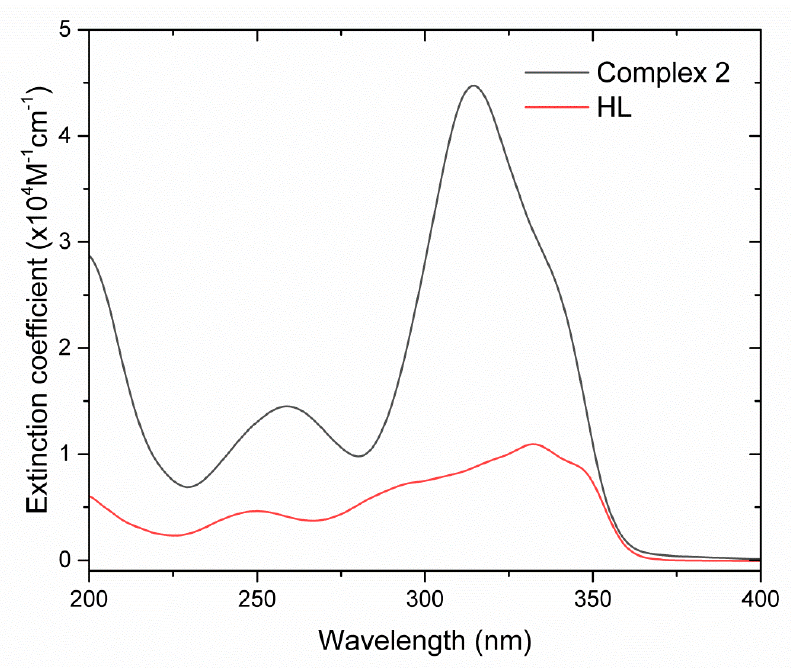
Figure 5. Absorption spectra of ligand 1 and complex 2 in MeCN solutions.